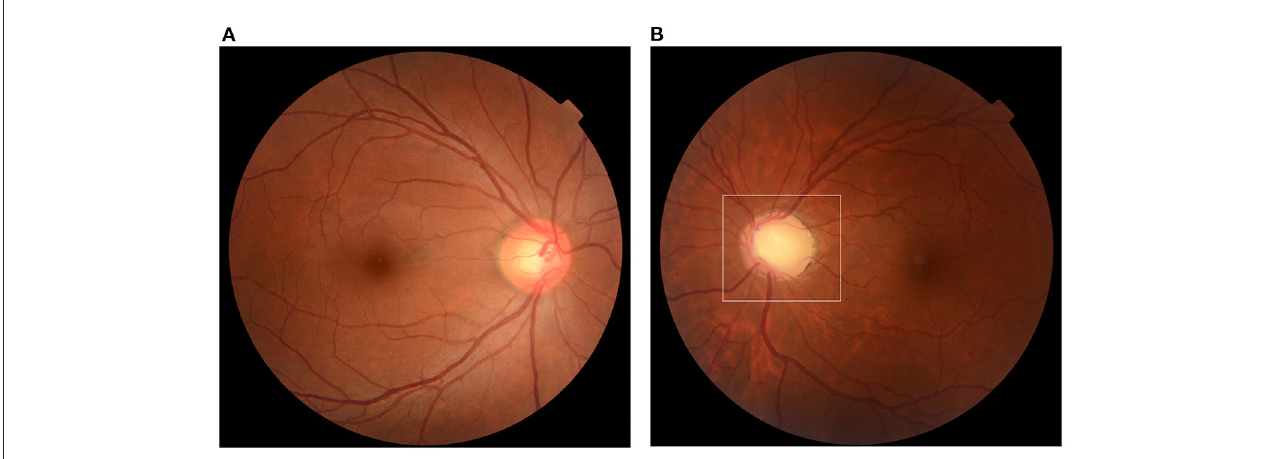
TABLE 2 The comparison of previous relapses and relapse following COVID-19 vaccination.